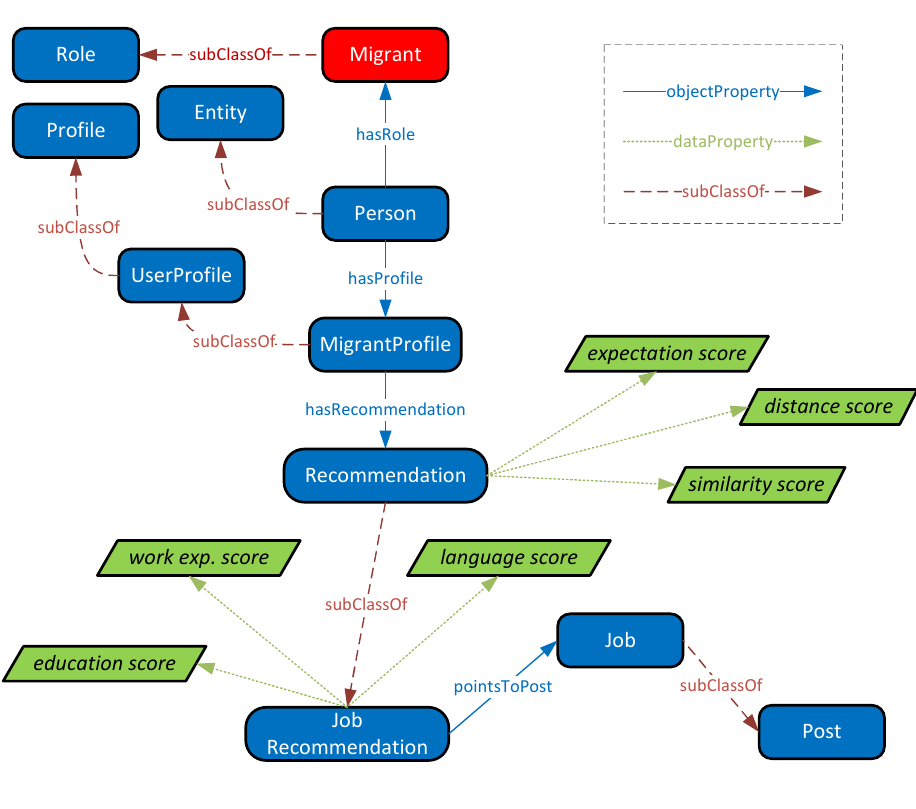
Figure 5. Recommendation representation. Table 1. Ontology metrics for the IMMERSE ontology are generated by